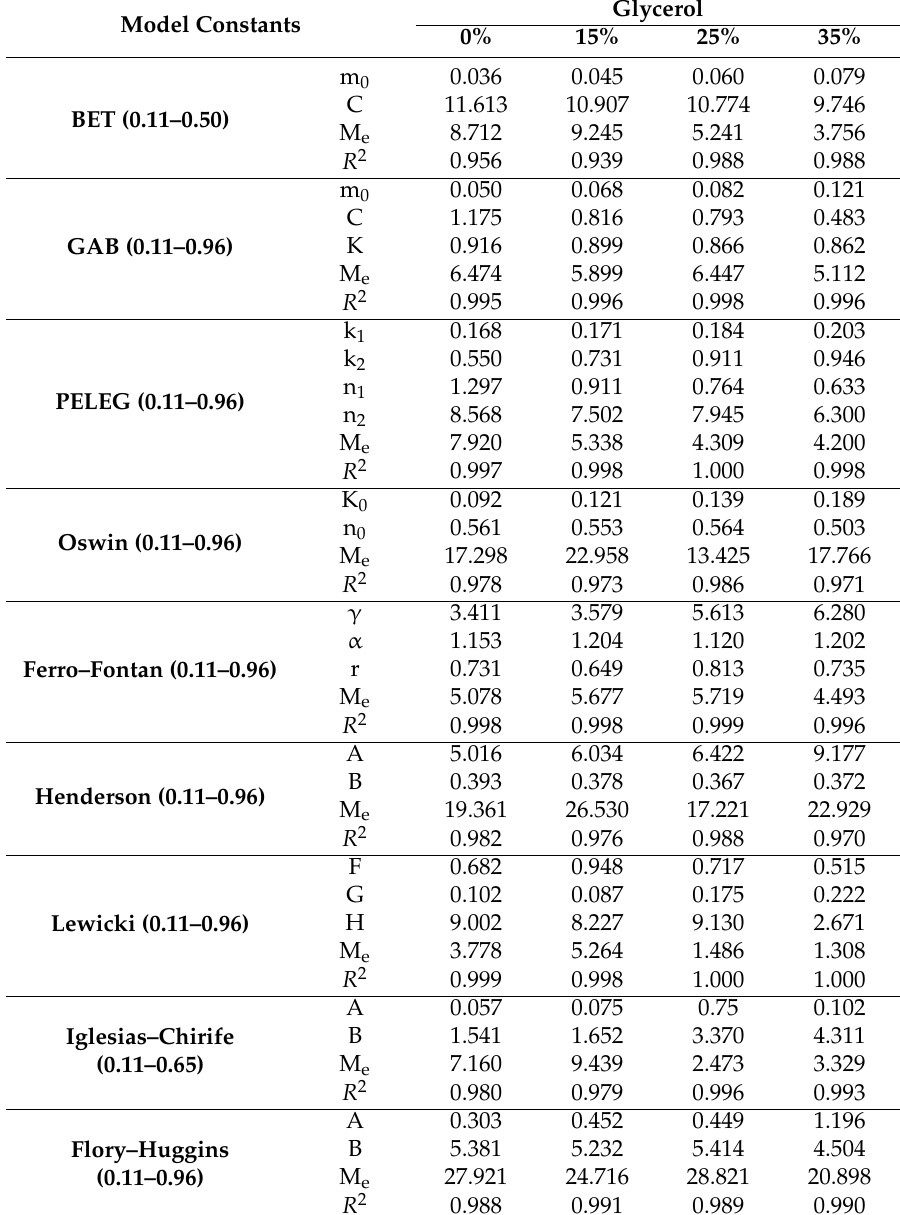
Table 5. Estimated model constants and values of coefficients and mean relative percentage deviation moduli for different pea starch films at 40 ˝